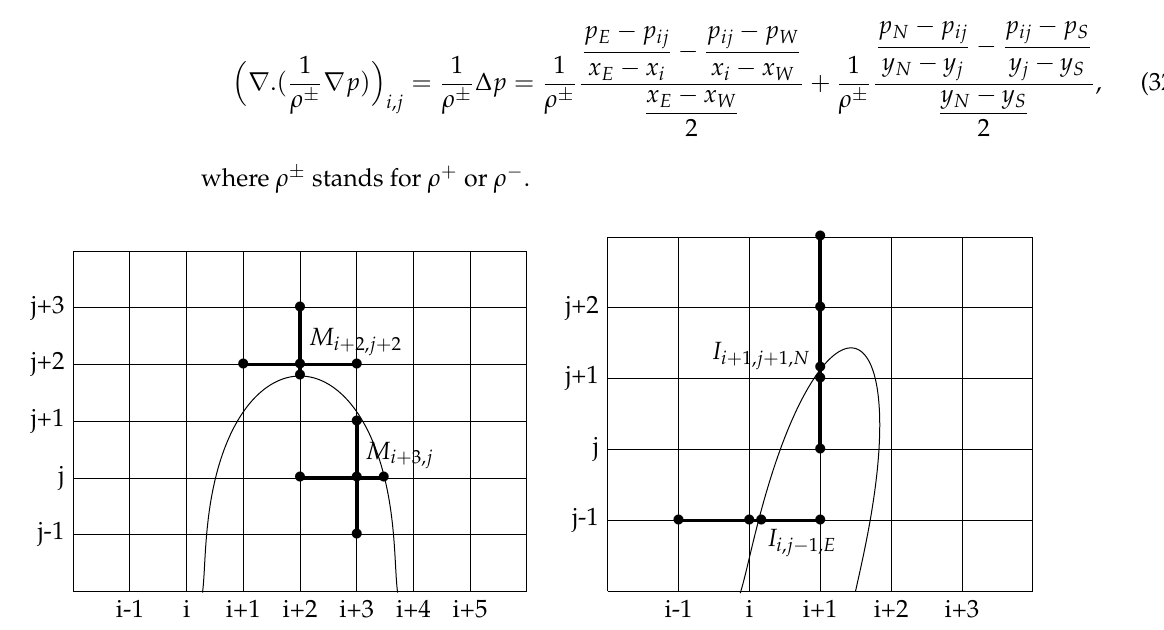
Figure 4. Left: points involved in the discretization of the elliptic operator at grid nodes M i + 2, j + 2 and M i + 3, j in black, right: Example of stencils for the discretization of jump conditions. Points involved in the discretization of the x-derivative of the pressure at interface point I i , j − 1, E and of the y-derivative of the pressure at interface point I i + 1, j + 1, N in black. For I i , j − 1, E both derivatives are expressed with second-order accuracy while for I i + 1, j + 1, N the left derivative is expressed with second-order and the right derivative with first-order